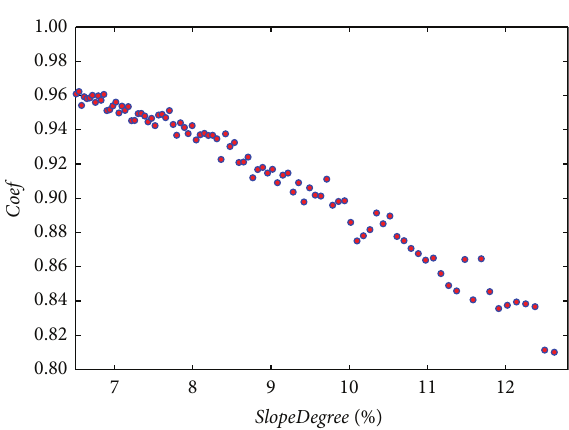
Figure 6: Relationship between 𝑆𝑙𝑜𝑝𝑒𝐷𝑒𝑔𝑟𝑒𝑒 and 𝐶𝑜𝑒𝑓 .